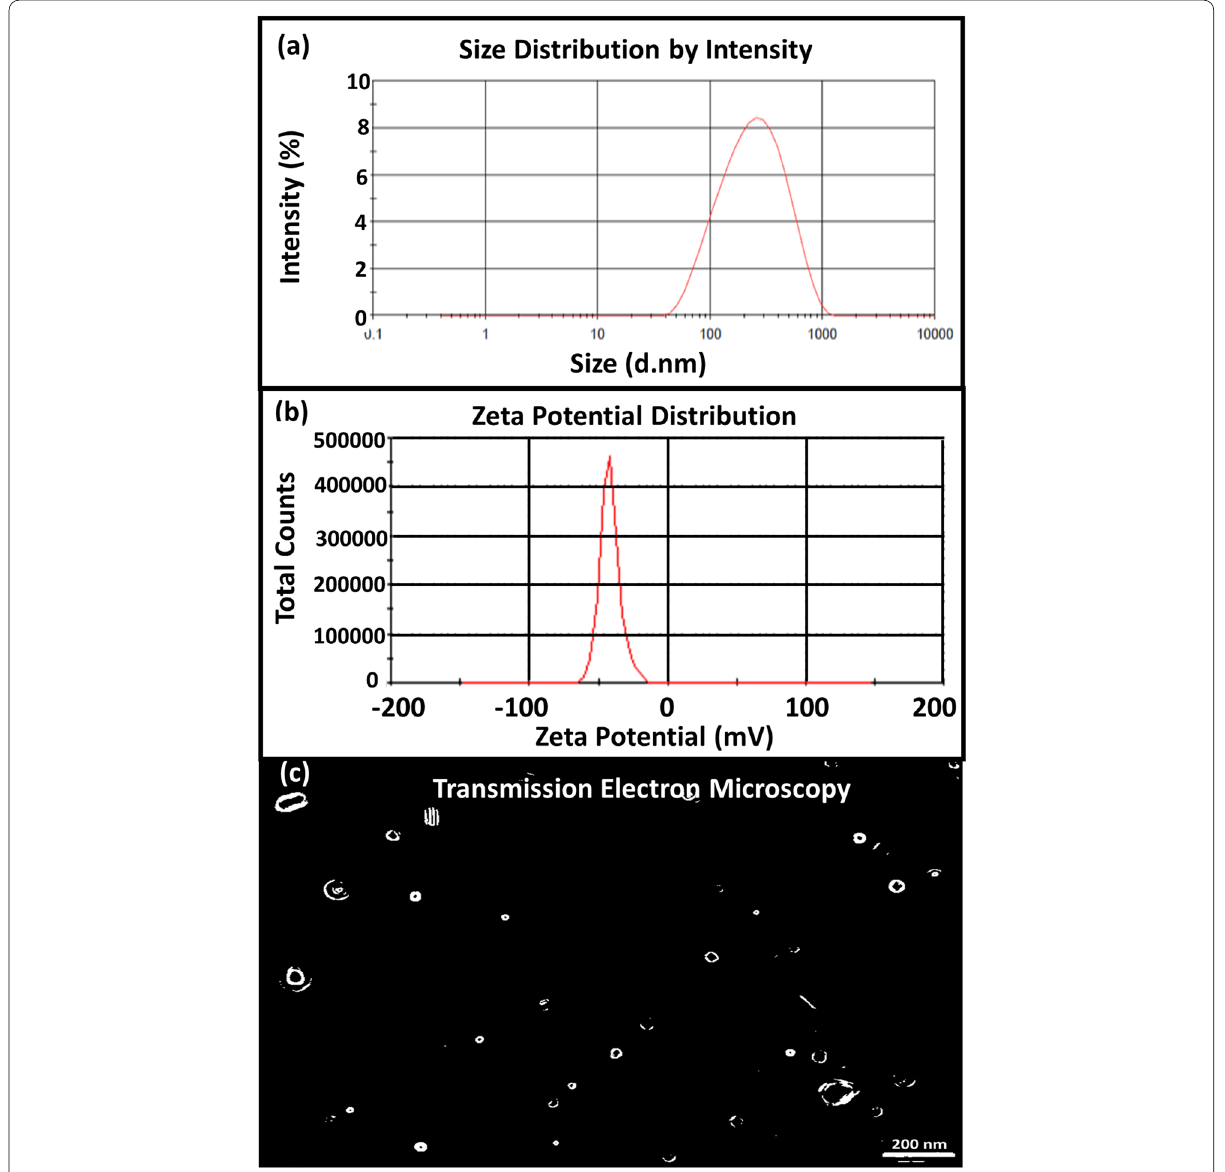
Fig. 2 a Vesicle size of the optimized batch, b zeta potential of the optimized batch, and c transmission electron microscopy (TEM) image of